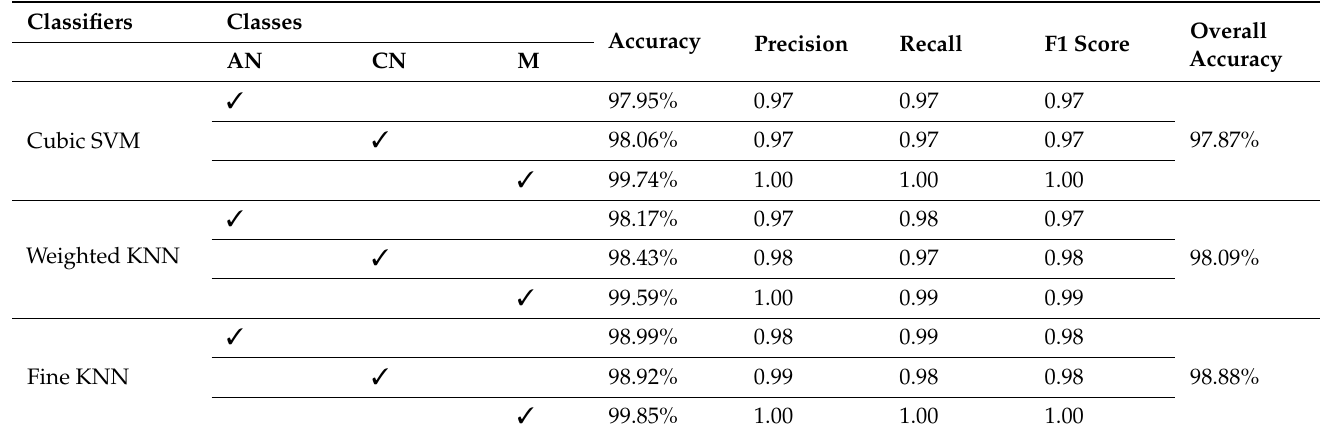
Table 9. Proposed classification model results on PH2.